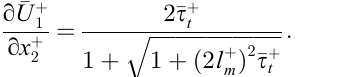
¼ 1 þ b n (cid:5) 1, in the viscous sublayer. when n P t 2 2 ¼ 1 at the wall, The pro fi le veri fi es the constraints (cid:1) s þ t ¼ 0 and d (cid:1) s þ = d n ¼ 0 for n = 1, that is at the edge and (cid:1) s þ t t 2 2